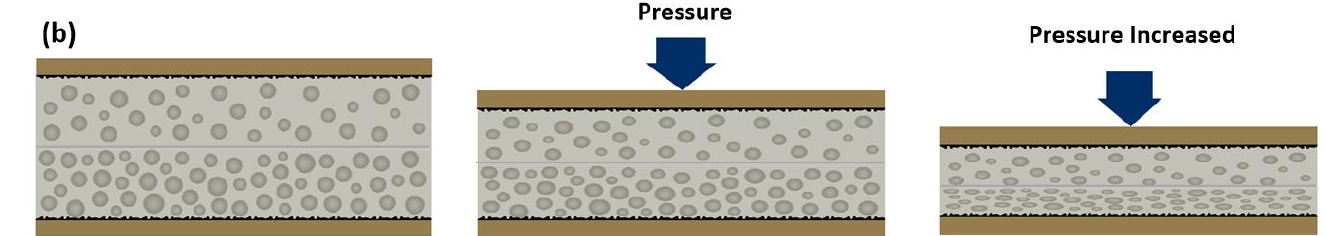
Figure 1. The structural diagram and the working principle of the sensor: ( a ) the structural diagram of the sensor; ( b ) the cross-section view and the working principle of the sensor.